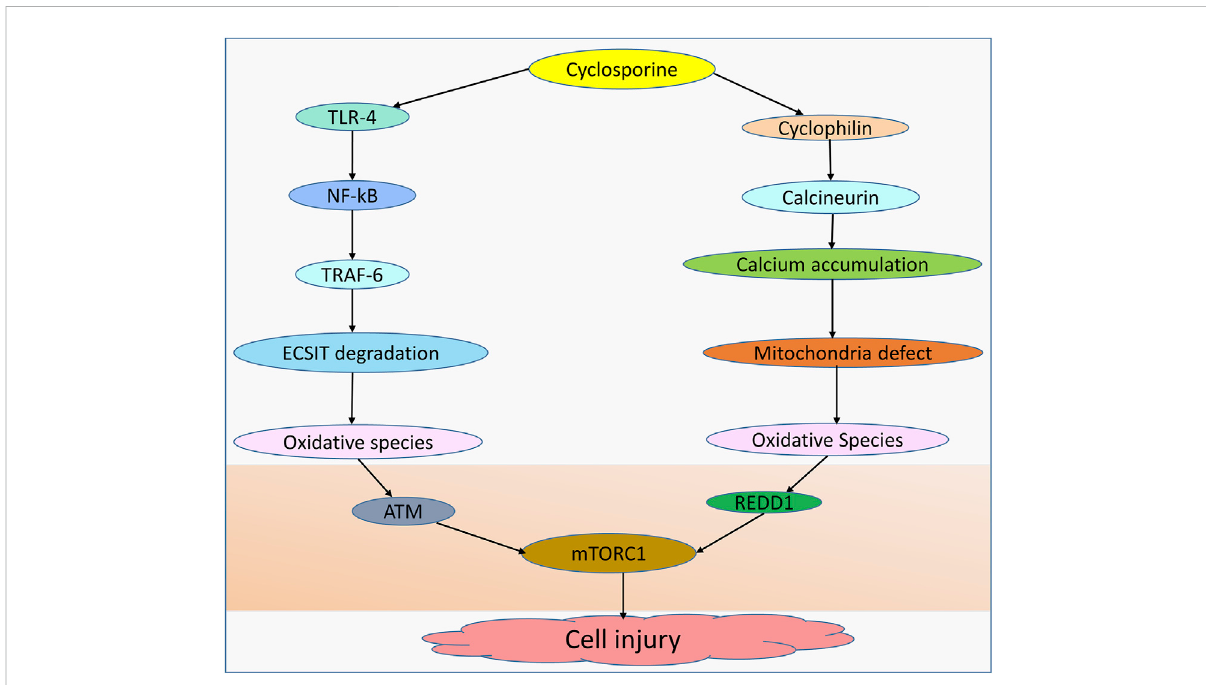
FIGURE 1 Cyclosporine-induced cell injury. Cell injury can be induced by cyclosporine through different mechanisms. Cyclosporine can interact with TLR-4 in the NF-kB pathway, allowing TRAF-6 to translocate into the nucleus and induce ECSIT degradation, leading to the production of oxidative species. Cyclosporine-cyclophilincan mediatemitochondrialdysfunction due to theaccumulationofcalciumdeposits,leadingto oxidative species generation. Oxidative species inhibit the expression of mTORC1 by upregulating ATM and REDD1, resulting in cell